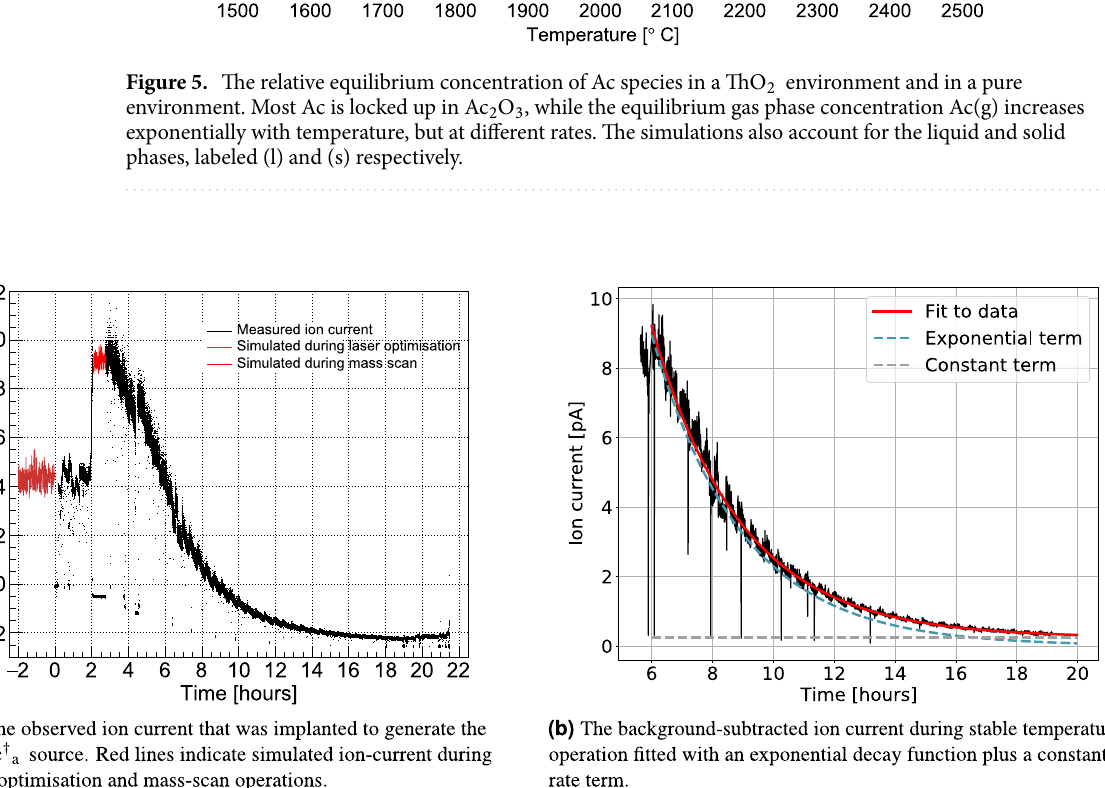
Figure 6. The ion current during collection of the 225 Ac † a